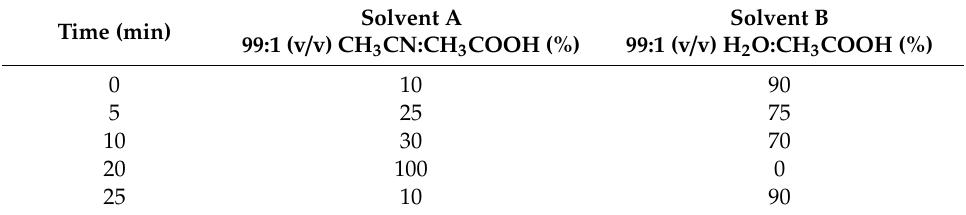
Table 3. Gradient program used in the HPLC